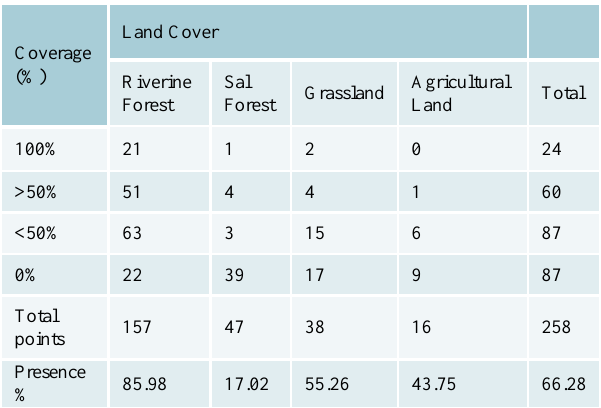
Figure 6. Potential invasion map of Chitwan